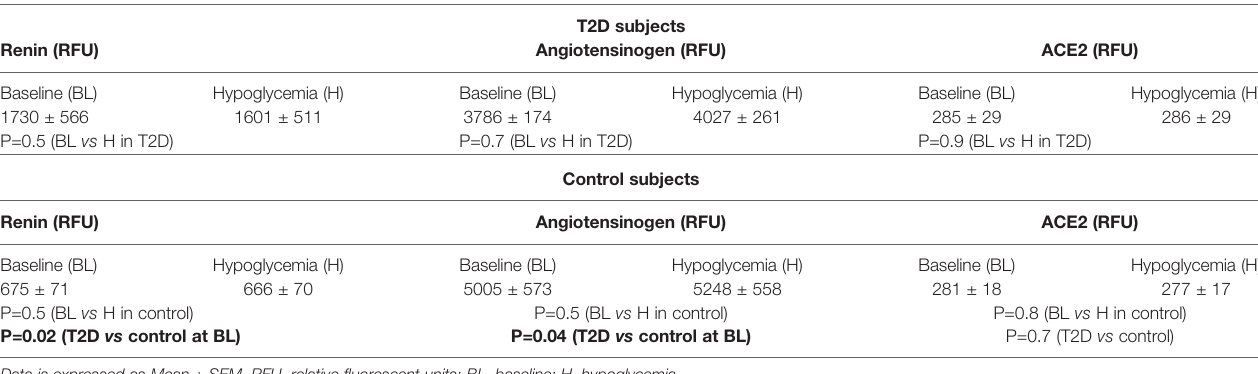
TABLE 2 | Circulating levels of renin angiotensin system (RAS)-related proteins at baseline and in response to hypoglycemia in control subjects and in subjects with T2D.